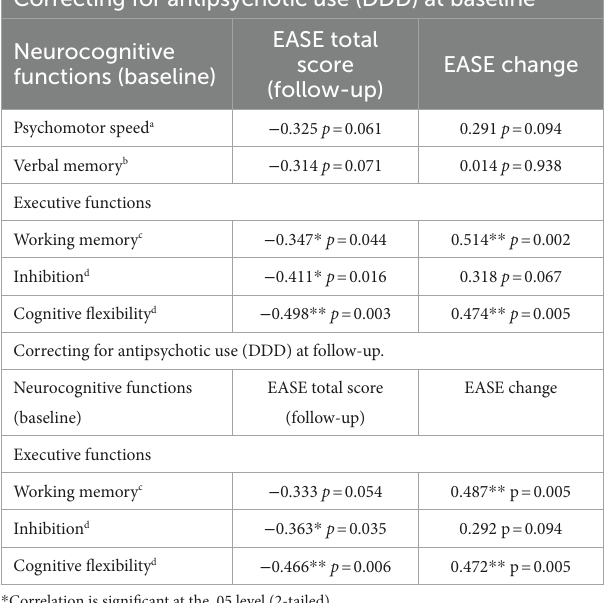
TABLE 2 Partial correlations between neurocognition at baseline and SDs at follow-up and change in SDs. Correcting for antipsychotic use (DDD) at baseline Neurocognitive functions